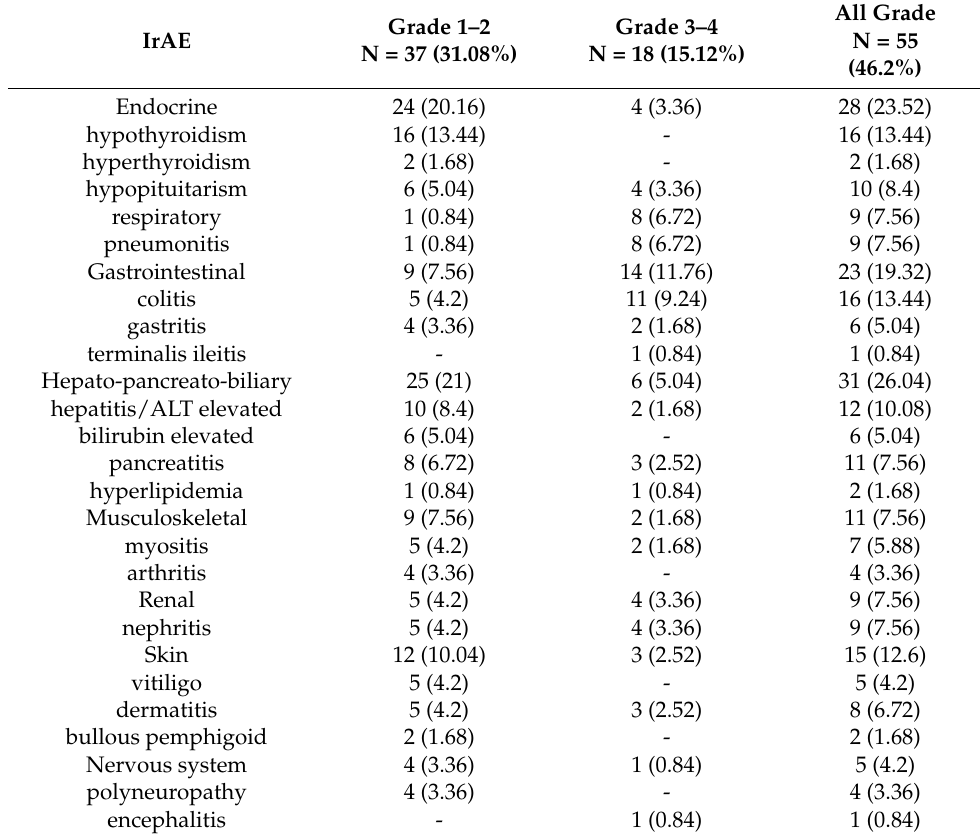
Table 6. The occurrence of immune-related adverse events among the investigated patients.